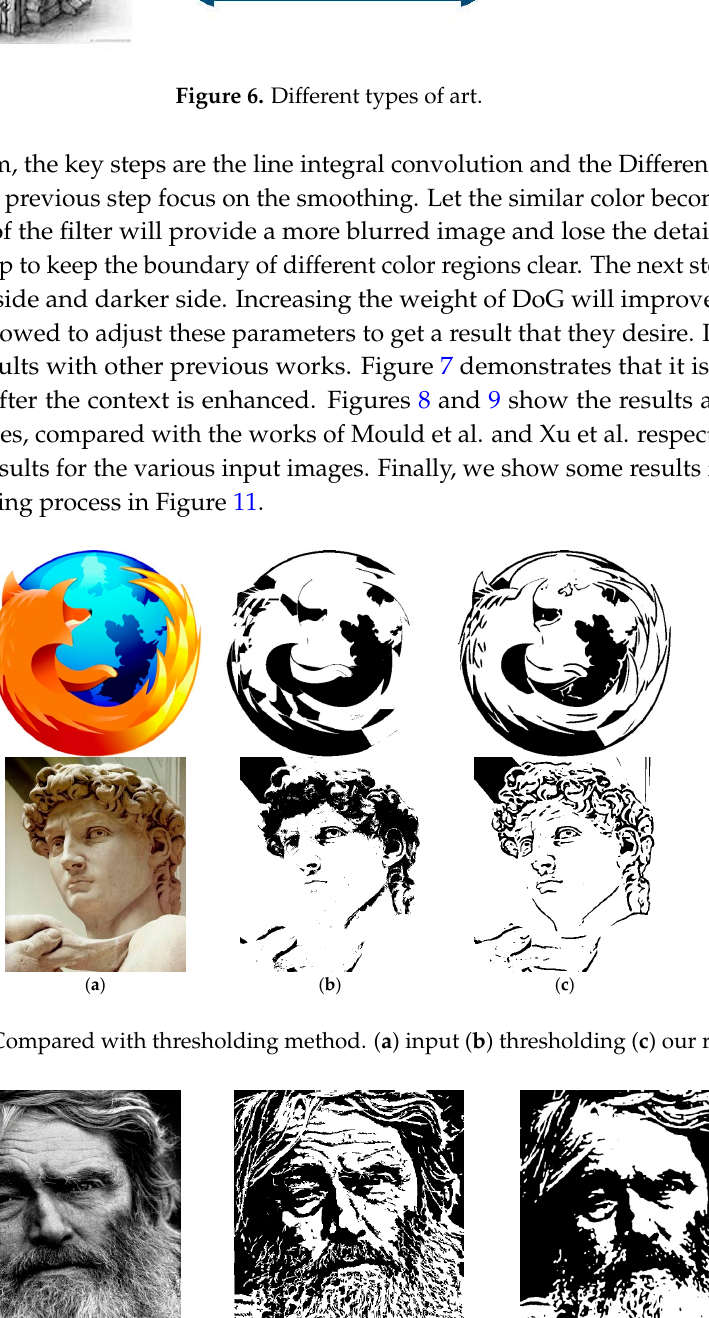
Figure 8. Compared with Stylized Black and White Images from Photographs [24]. ( a ) input ( b ) Mould and Grant [24] ( c ) our result.